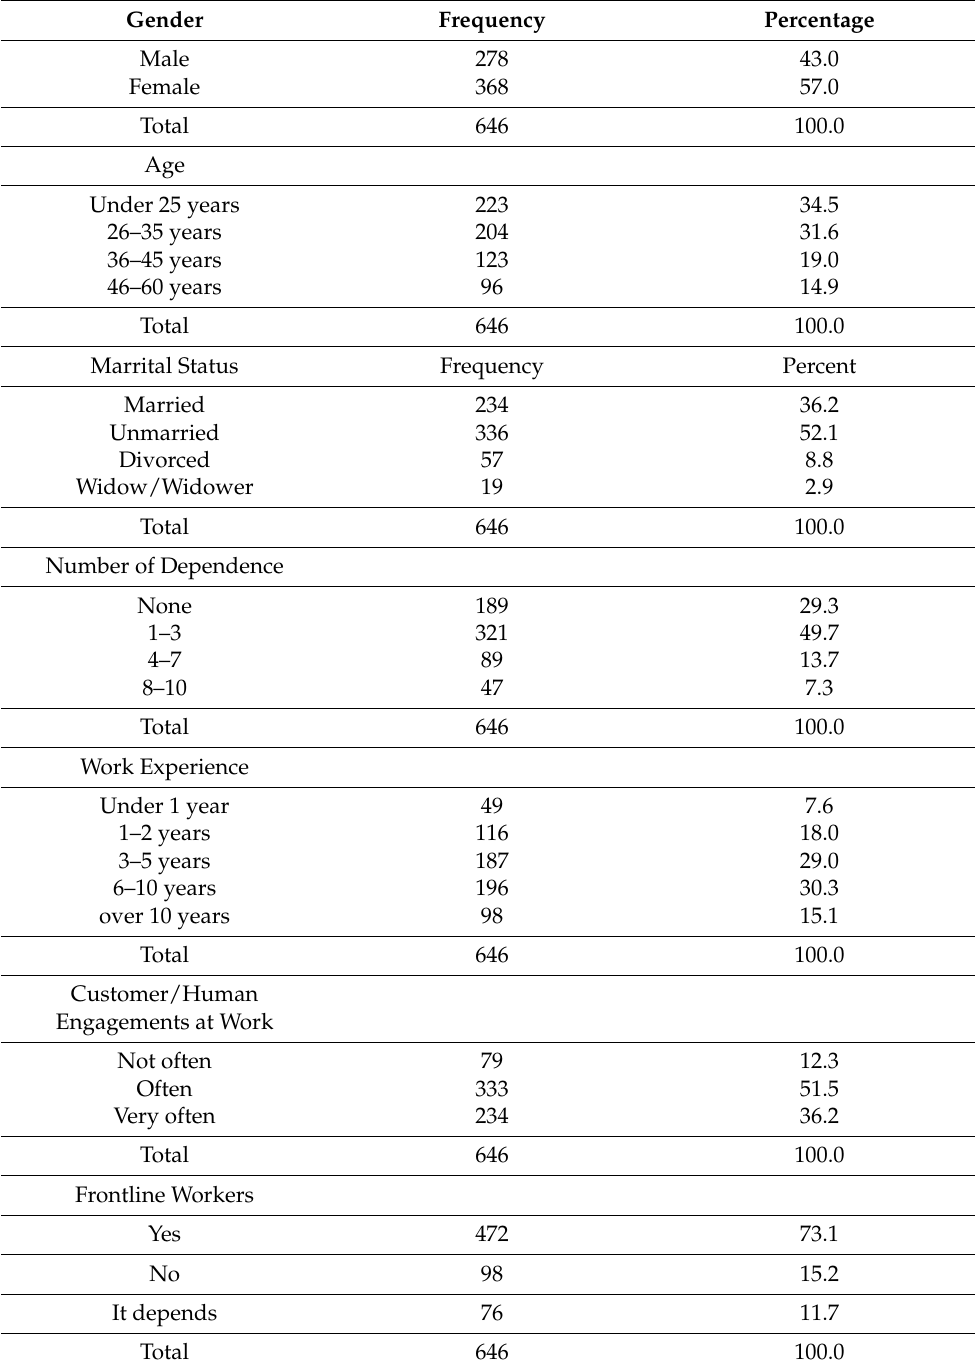
Table 1. Description of